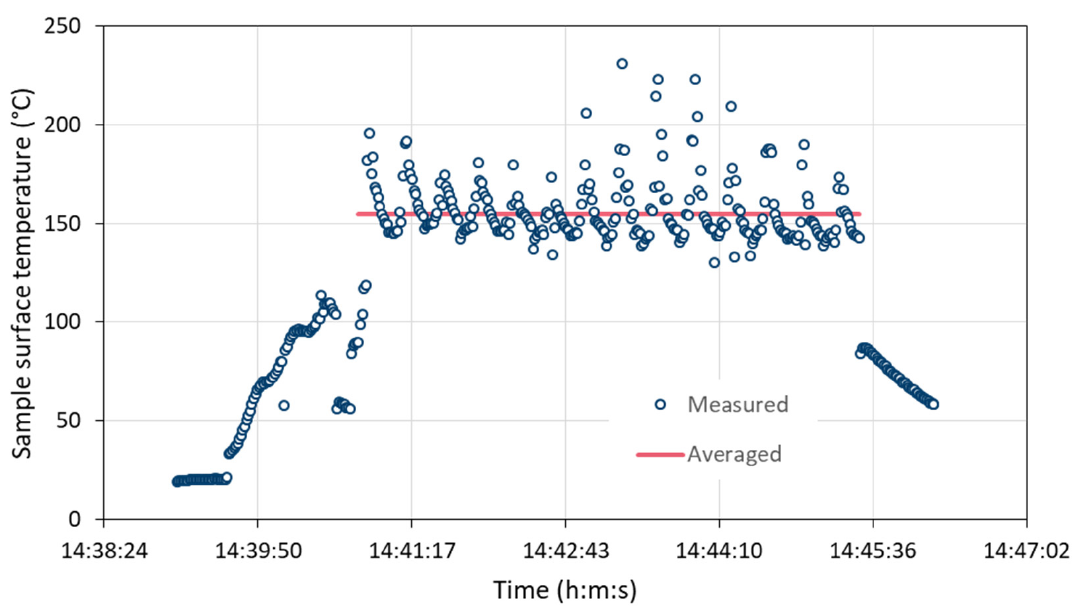
Figure 9. Example for measured and averaged sample surface temperature during coating deposition.